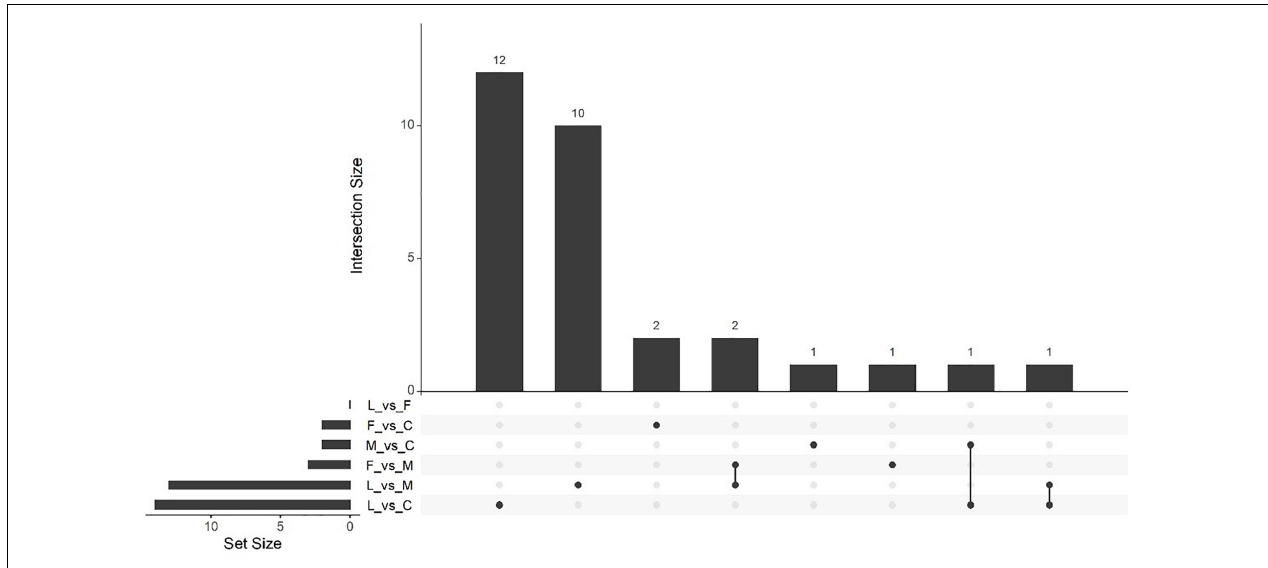
FIGURE 9 | UpSetR plot showing numbers of upregulated differentially expressed genes (DEGs), ( p < 0.05) and Log2 fold change ( ≥ 2.0). Any DEGs common to plant treatments are shown by connected dots. Cumulative numbers of DEGs are calculated by adding numbers associated with dots in each respective treatment